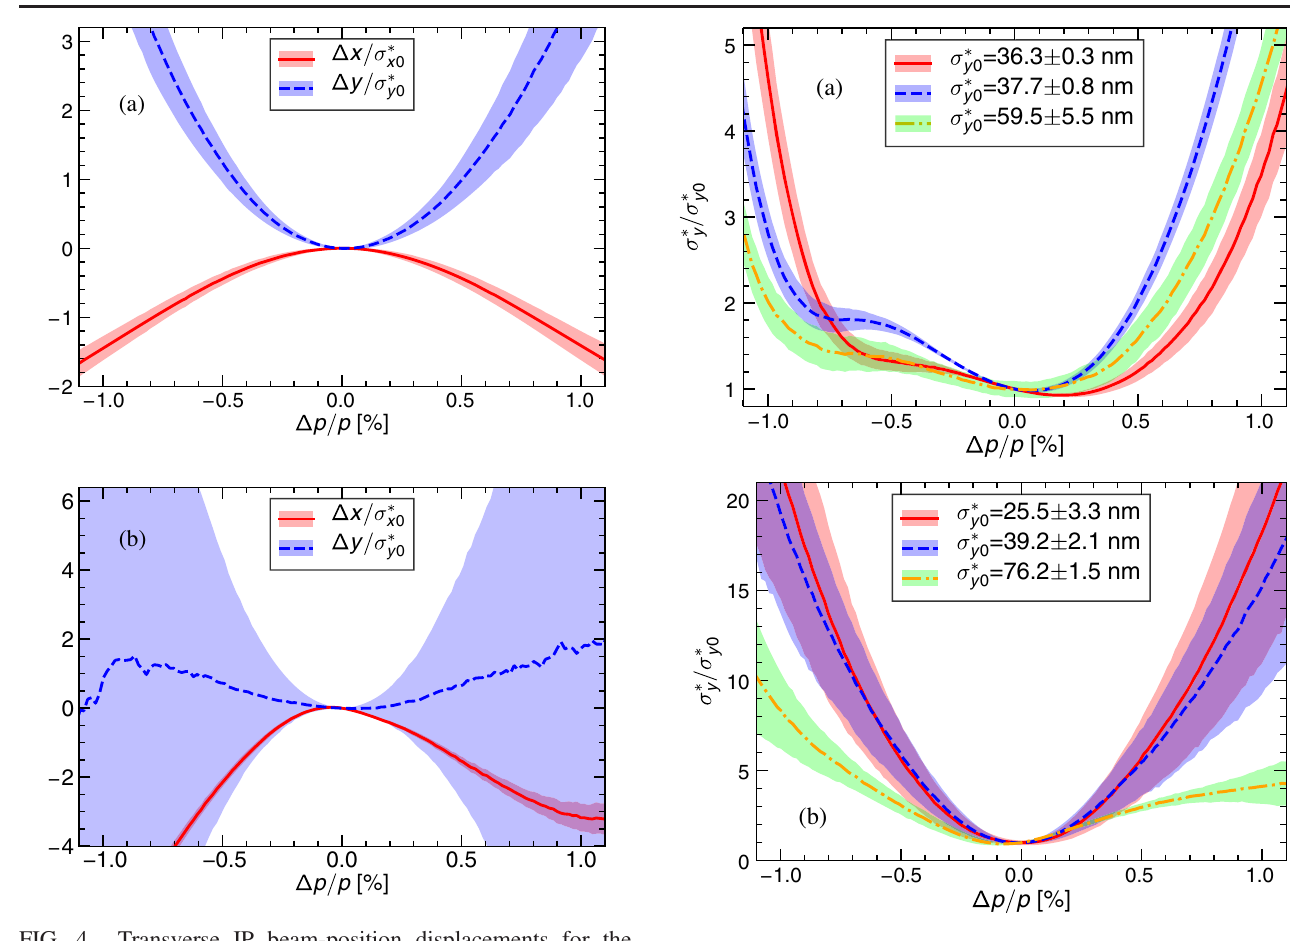
FIG. 4. Transverse IP beam-position displacements for the 10 β (cid:1) 1 β (cid:1) β (cid:1) (b) optics. FIG. 5. Momentum bandwidths versus on-momentum IP vertical x y optics (a) and ultralow beam size for the 10 β (cid:1) x 1 β (cid:1) y optics (a) and ultralow β (cid:1) optics (b). The on-momentum beam sizes of 36 . 3 (cid:3) 0 . 3 , 37 . 7 (cid:3) 0 . 8 and 59 . 5 (cid:3) 5 . 5 nm in (a) are obtained with careful linear and nonlinear knobs corrections, linear knob corrections, and preliminary linear knob corrections (one iteration), respectively. The on-momentum beam sizes of 25 . 5 (cid:3) 3 . 3 , 39 . 2 (cid:3) 2 . 1 and 76 . 2 (cid:3) 1 . 5 nm in (b) are achieved after applying complete linear and nonlinear knobs corrections, linear knob corrections plus one iteration of nonlinear knobs, and linear knob corrections,